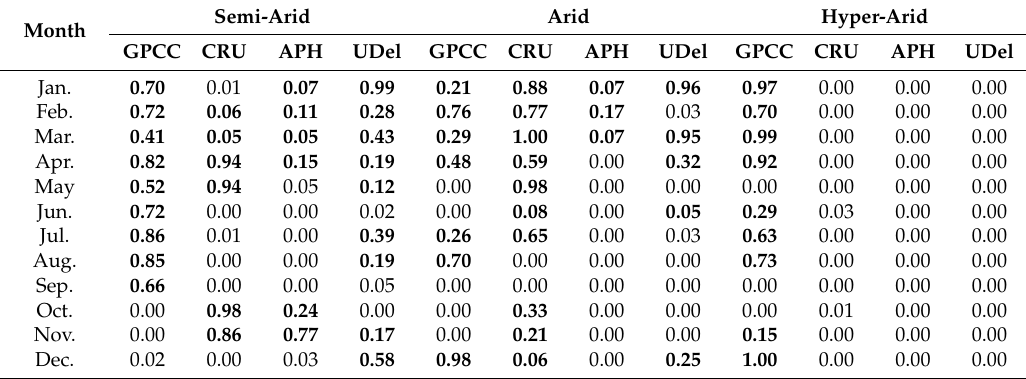
Table 2. Results of the Anderson–Darling test of data